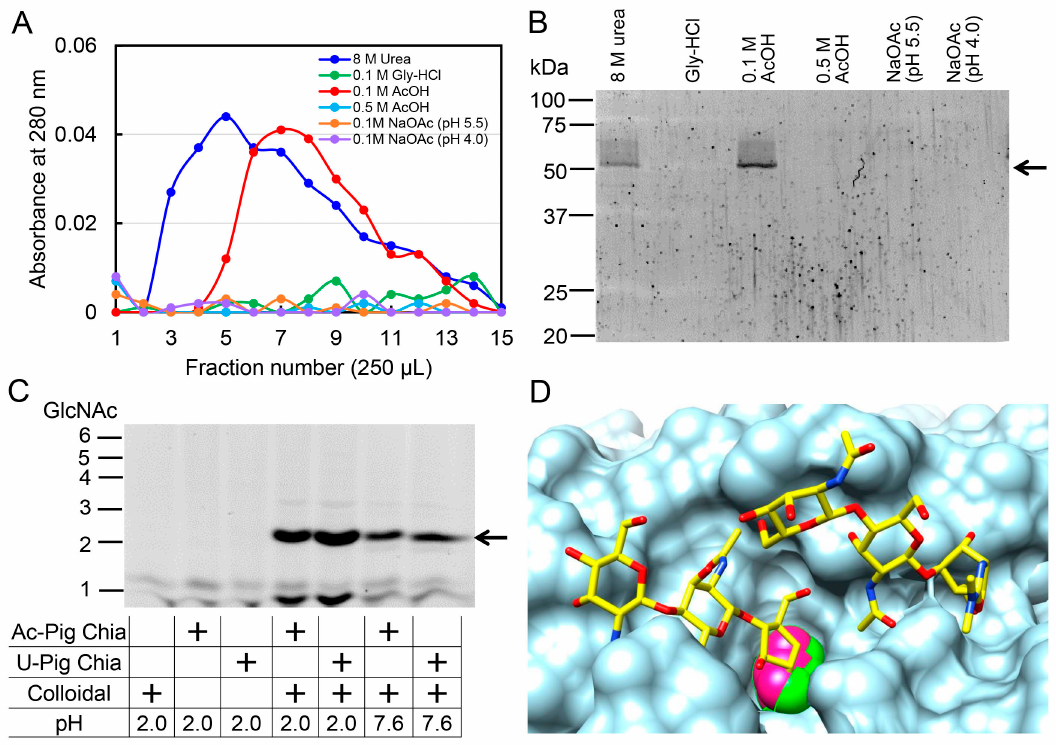
Figure 5. Native Chia can be purified from pig stomach tissues using a chitin column and acetic acid. The soluble fraction of pig stomach was applied onto the column. The bound Chia was eluted from the column as described in Figure 1. ( A ) Elution profiles of pig Chia from the chitin column. ( B ) SDS-PAGE analysis of the protein fractions. Arrow highlights the positions of the Chia protein. ( C ) Comparison of the chitinolytic properties between acetic acid-Chia and 8 M urea-Chia. Colloidal and crystalline chitin substrates were digested by Chia and resulting products were analyzed by the FACE method. Arrow indicates the position of (GlcNAc) 2 . ( D ) Composite surface representation of the chitinase (PDB ID: 3N12) with the superimposed inhibitor allosamidin (PDB ID: 1HKK, yellow-stick model). The acetic acid molecules of 3N12 (pink) and 4NZC (green) are shown at van der Waals radii.